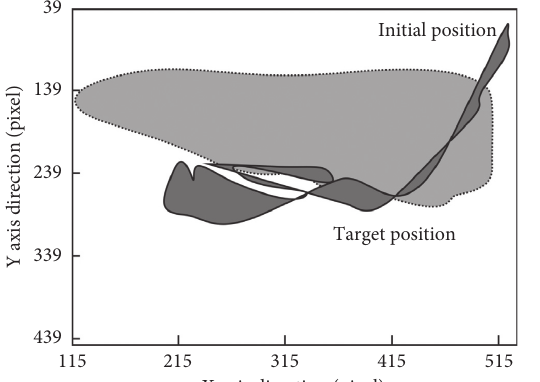
Figure 8: Athlete’s sports trajectory under the real-time analysis method of posture with CAD-assisted intelligent